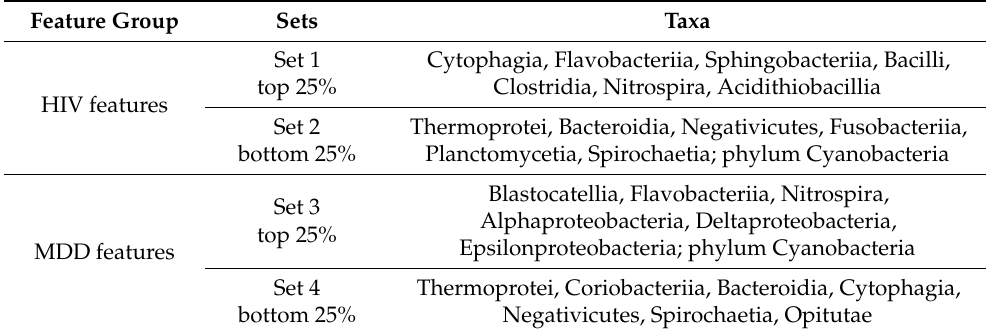
Figure 1. Comparison of the relative abundance of the taxa using log ratios of the ranked taxa sets in different subgroups. ( a ) Features distinguishing PWH from PWoH ( t -test, HIV − /MDD − versus HIV − /MDD+ Cohen’s D = − 0.63, BH-corrected p = 0.023; HIV − /MDD − versus HIV+/MDD − Cohen’s D = − 0.95, BH-corrected p = 0.020) and ( b ) features distinguishing MDD+ from MDD − ( t -test, HIV − /MDD − versus HIV − /MDD+ Cohen’s D = − 0.70, BH-corrected p = 0.038; HIV − /MDD − versus HIV+/MDD − Cohen’s d = − 0.75, BH-corrected p = 0.043). ( c ) HIV-/MDD- have a lower ratio of LPS producers than HIV − /MDD+ (Cohen’s D = − 0.66, BH-corrected p = 0.028). ( a – c ) Center lines represent the mean, the top of the box represents the upper quartile, the top whisker represents the maximum value (excluding outliers), the bottom of the box represents the lower quartile, and the lower whisker represents the minimum value (excluding outliers). * Indicates significant differences (BH-corrected p < 0.05) between groups. The list of features in each set are present in Table 2. Table 2. Sets of identified taxa used in log ratio computations using Songbird